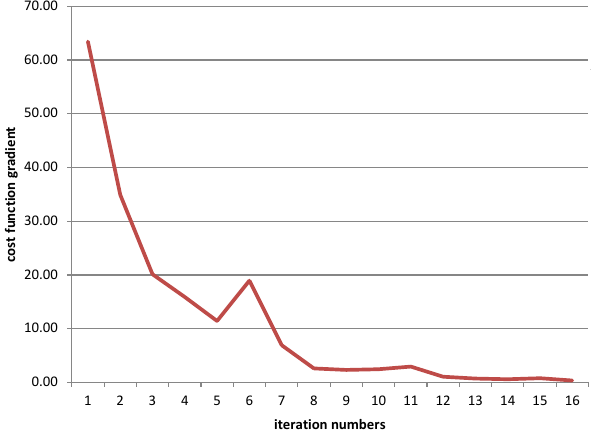
Fig. 6. DMI-BSHcmod bathymetry and domain setup. The bathymetry shown in the figure is for the coarse grid. The red rect- angle frame outlines the inner fine